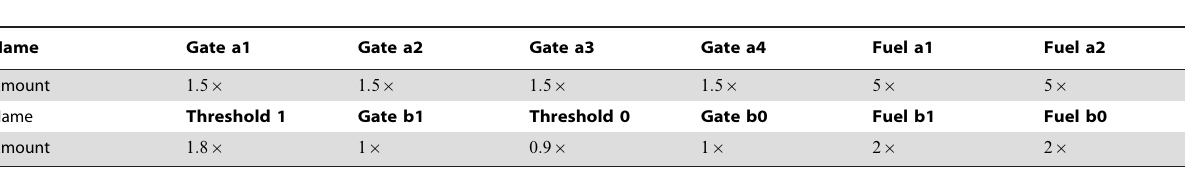
Table 1. The detailed amounts of involved DNA molecules in XOR logic